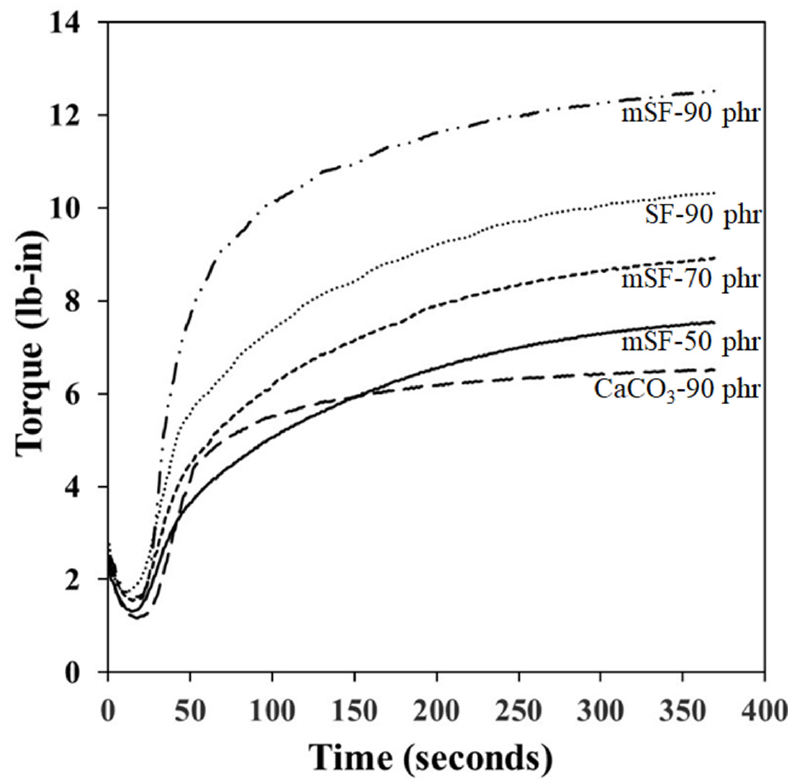
Figure 2. Cure behavior of SF, mSF and calcium carbonate as a rubber filler in EPDM foam insulation. Table 2. Mechanical properties of EPDM foam